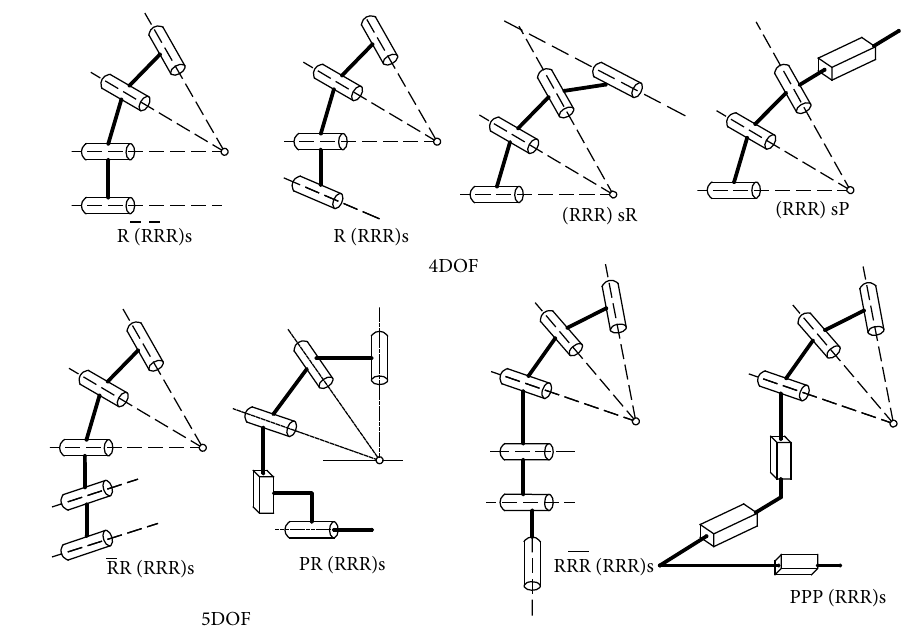
Figure 12: Con fi guration under multi-DOF.